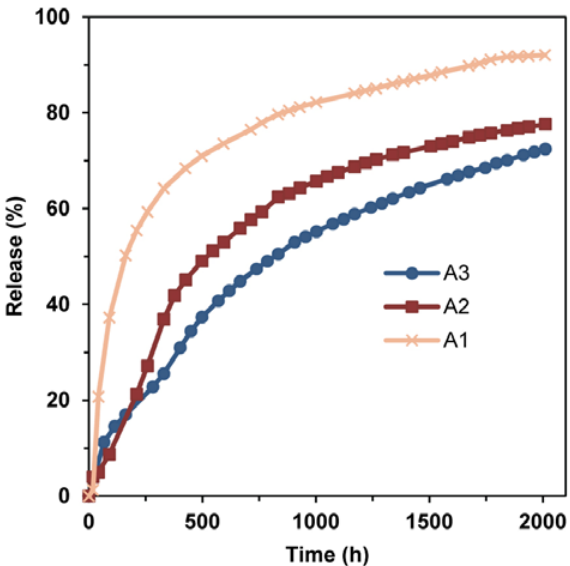
Figure 6. Orange oil release rate from microcapsules prepared with different chain extenders (EDA, DETA, PEG400, BD) in aqueous phase 2. The release was measured gravimetrically at 50 °C for 84 days (A3_EDA, B1_DETA, C1_PEG400,